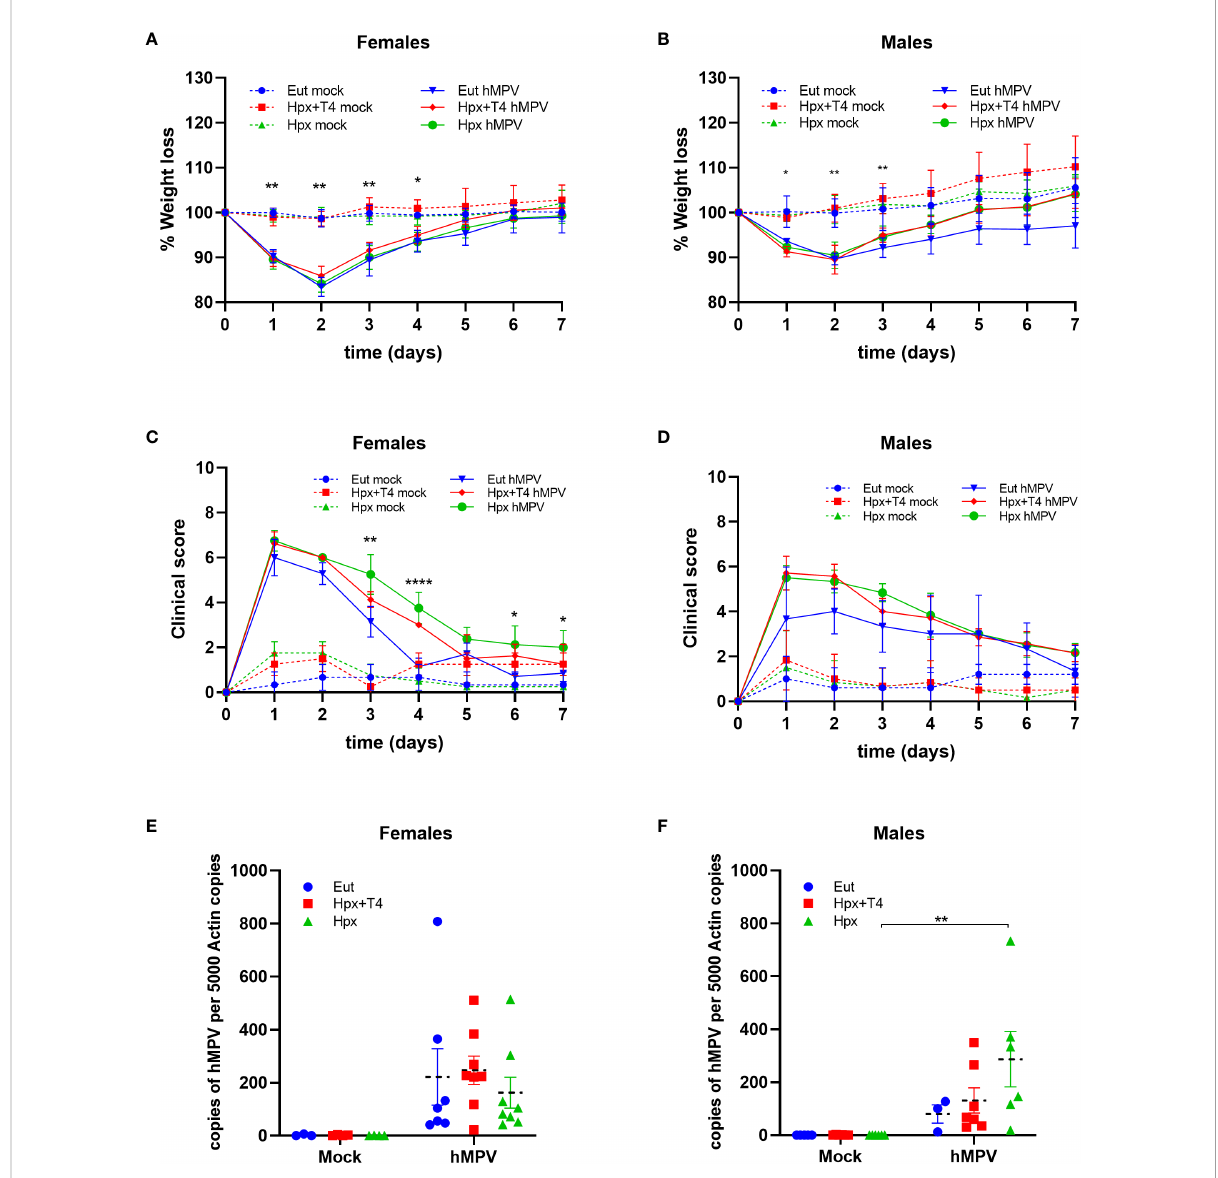
FIGURE 1 Male and female mice gestated under Hpx respond differently to hMPV infection. Mice from three experimental groups were infected with 1x10 6 PFU of hMPV or mock. The graph shows the body weight loss of female (A) and male mice (B) , and a signi fi cant difference was evaluated between infected and non-infected animal groups. Mice were monitored seven days post-infection to record the clinical score, and the daily value for female mice (C) and male mice (D) was graphed. Statistical differences between Eut and Hpx groups are plotted. Viral loads were quanti fi ed as copies of the N-hMPV gene for female (E) and male mice (F) . Data are shown as the mean ± SEM of at least three animals per group. *p < 0.05 **p < 0.01 and ****p < 0:0001 by two-way ANOVA and Tukey ’ s multiple comparisons